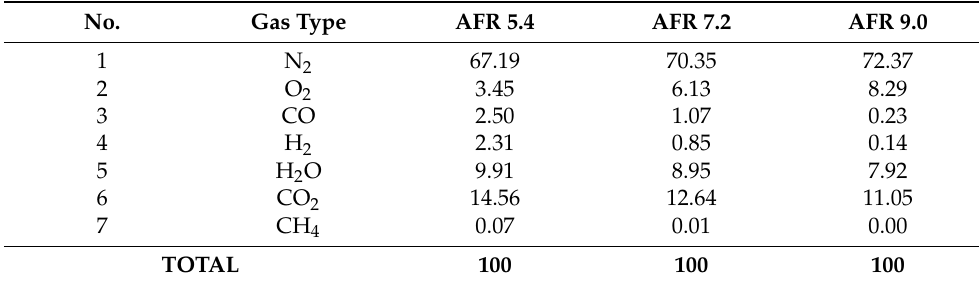
Table 4. Biomass pellet combustion gas components.